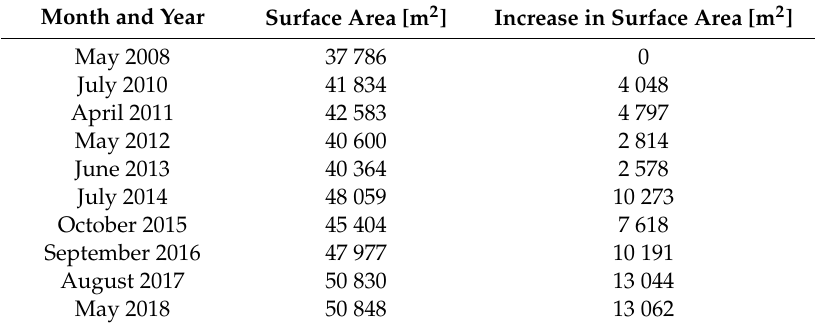
Table 3. The increase in the beach surface in Sopot due to the tombolo phenomenon, developed on the basis of satellite